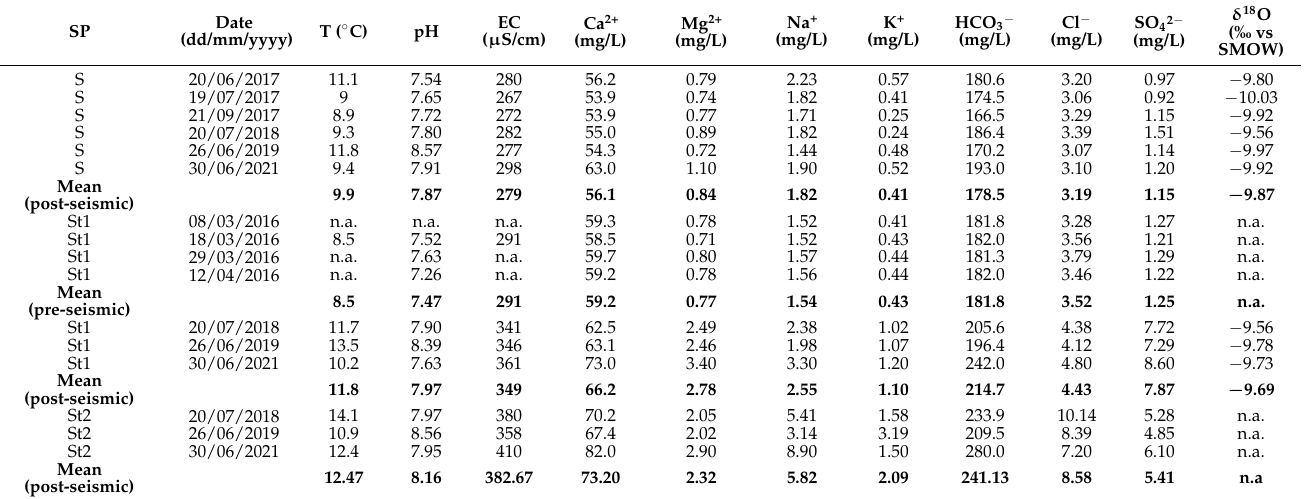
Table 2. Geochemical analysis results of 2017–2021 (post-seismic) sampling period on S, St1 and St2 measuring